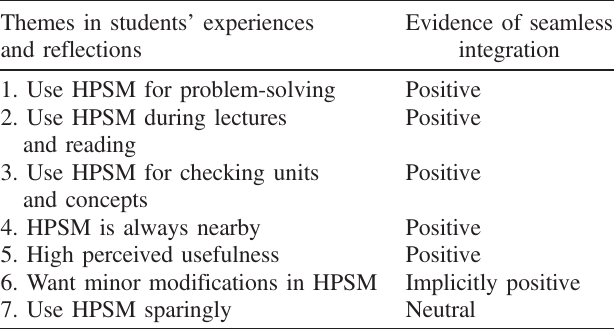
TABLE V. Themes from students ’ experiences and reflections on the hierarchical principle structure for